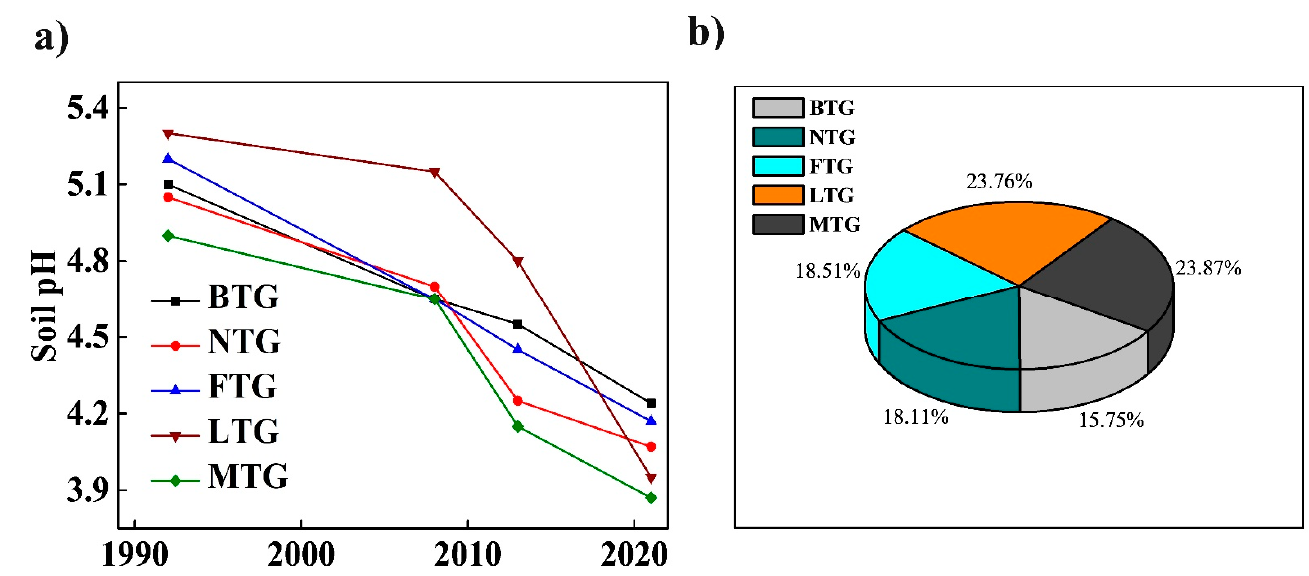
Figure 2. Changes in soil pH as influenced by long-term traditional fertilization. ( a ) Soil pH level and Figure-2. Changes in soil pH as influenced by long-term traditional fertilization. a ) Soil pH level